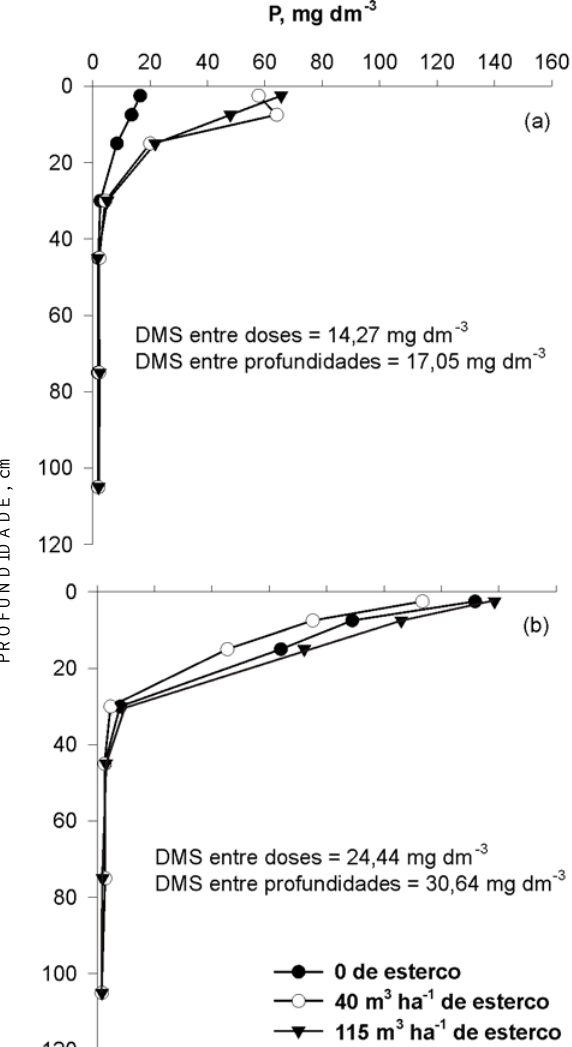
Figura 1. Teores de P no solo, em diferentes profundidades, considerando a aplicação de doses de esterco de suínos por três anos em Guatambu (a) e quatro anos em Chapecó (b). DMS = diferença mínima significativa para o teste de Tukey a 5